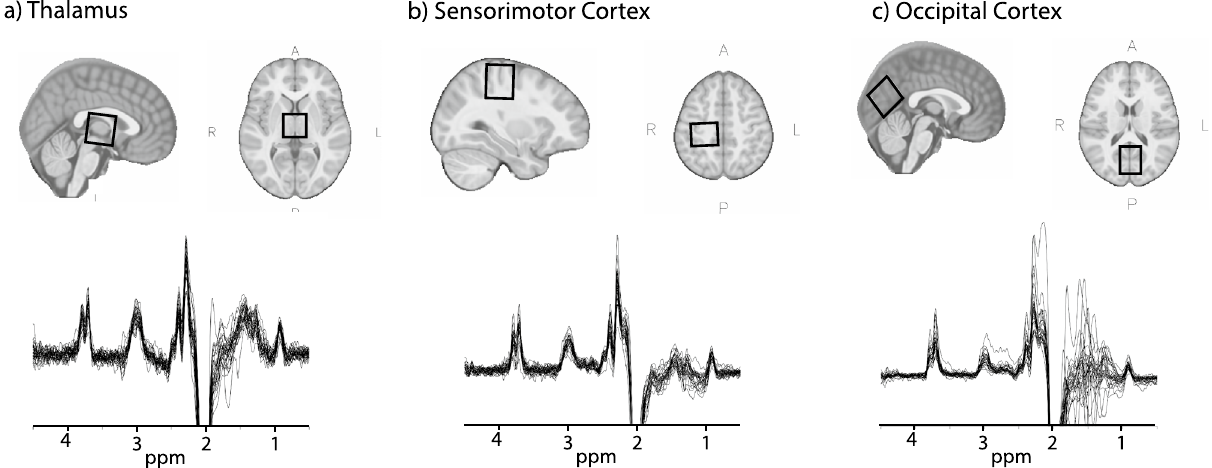
Figure 1. Example voxel placement and spectra from all participants from ( a ) Thalamus, ( b ) Sensorimotor cortex and ( c ) Occipital